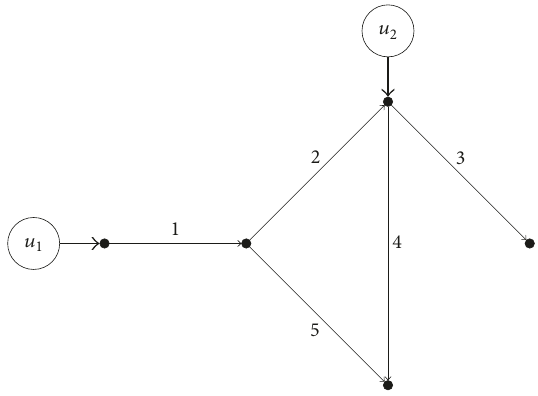
Figure 3: Road network with | E | = 5 edges and two controls 𝑢 1 , 𝑢 2